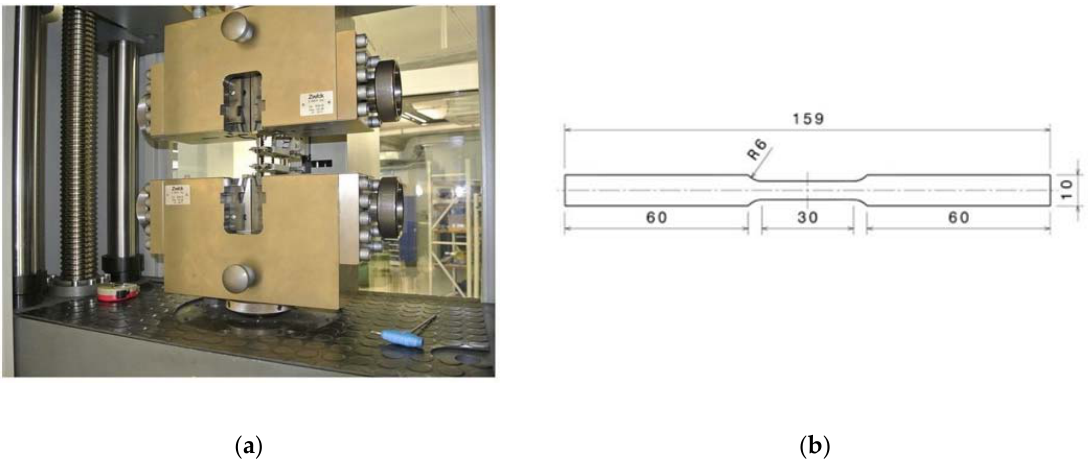
Figure 1. ( a ) Zwick / Roell testing device; ( b ) the sheet specimen for the tensile test.